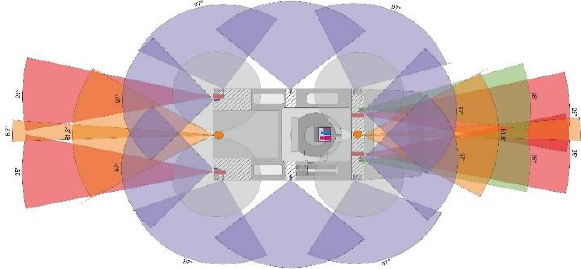
Figure 1. Ten short focus cameras (purple), two long focus cameras (green), four LiDARs (grey circles), two PTZ cameras (orange), four SWIR cameras (light red) Hardware processing part consist of seven computing units –